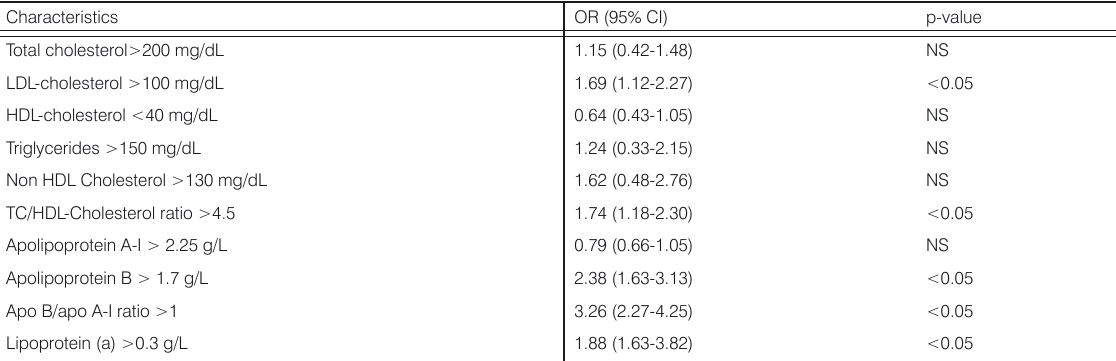
Table 4. Risk for future coronary artery disease, by lipid and apolipoproteins levels